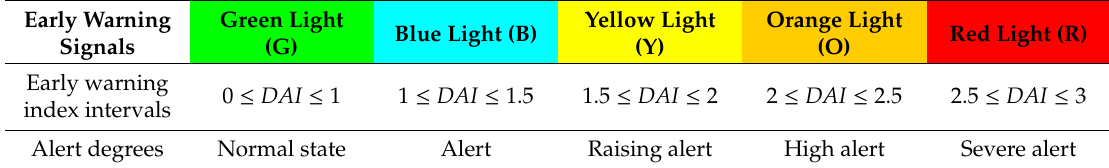
Table 3. Determination of DAI (drought alert index) alert intervals.